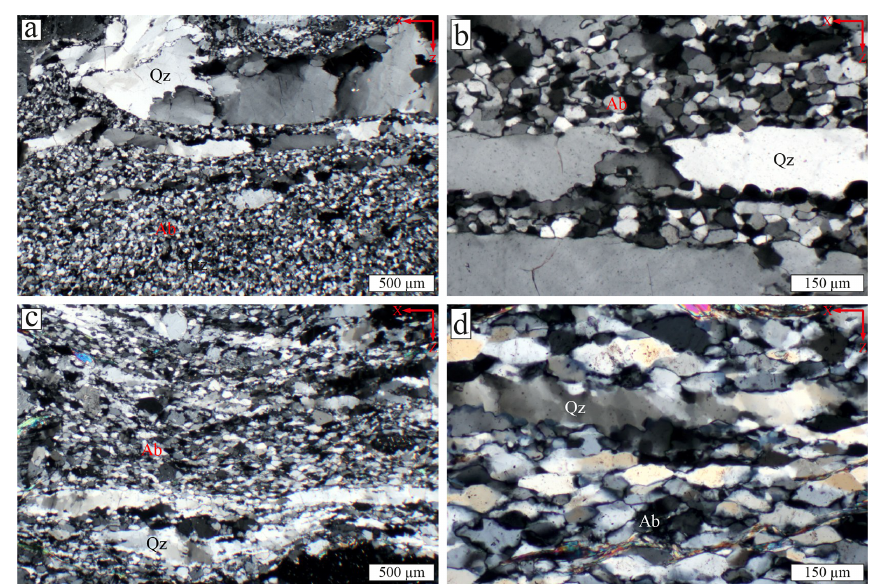
Figure 9. Polarized light micrographs taken with crossed polarizers showing the two types of quartz–albite matrix microstructure. (a, b) Type A matrix is characterized by coarse quartz layers and albite layers with isometric small grains, sample FH5. (c, d) Type B matrix is charac- terized by albite layers characterized by coarser and elongated grains parallel to the foliation, and fine-grained, dynamically recrystallized quartz layers, sample